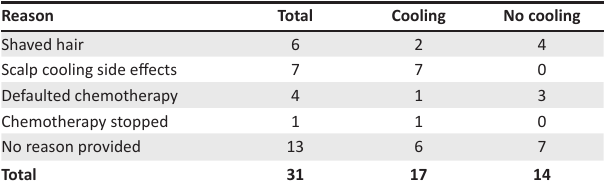
TABLE 1: Reasons for withdrawal.